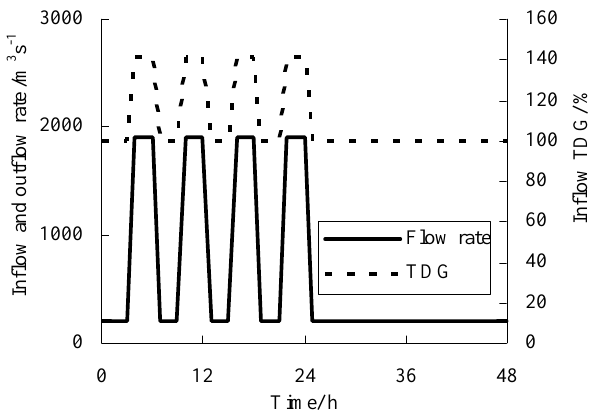
Fig. 5. The flow and TDG boundary conditions for Case